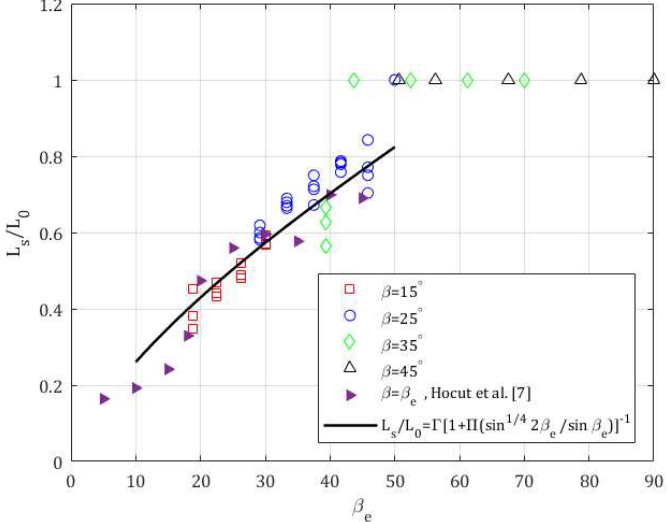
Figure 3. The dimensionless flow separation distance L s / L 0 as a function of the effective angle β e , which incorporates the plateau with Π = 7.4 and Γ = 8.8. The data of no plateau D = 0, is taken from Hocut et al. [7].